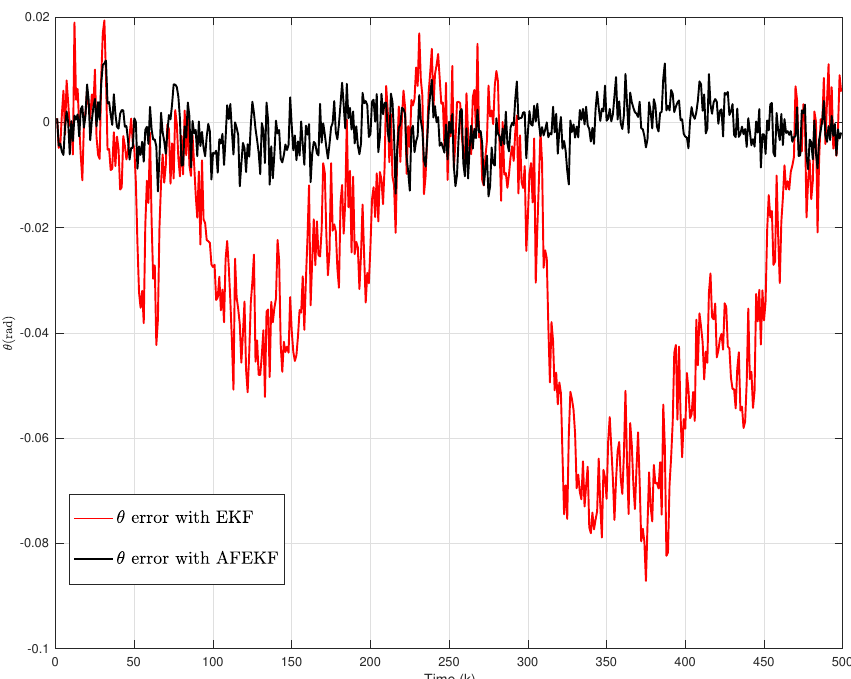
Figure 9. Robot’s angle errors under stochastic bias.